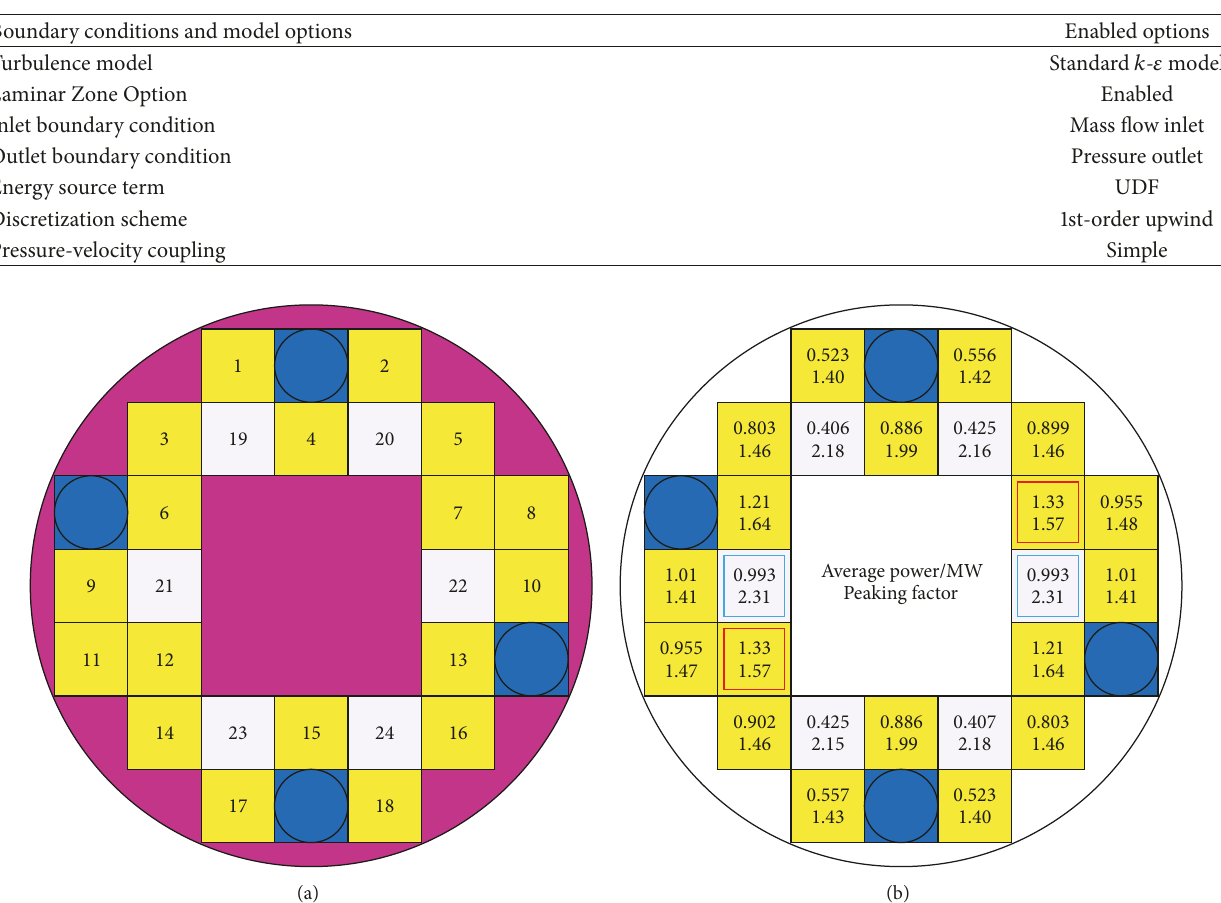
Table 1: Boundary conditions and model options.